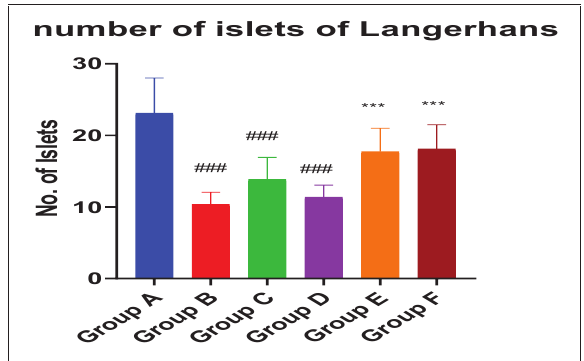
Fig-2: Comparison of mean number of islets of Langerhans among groups A,B,C,D,E and F ### shows p-value is <0.001 when compared to group A. *** means p-value is <0.001 as compared to group B.